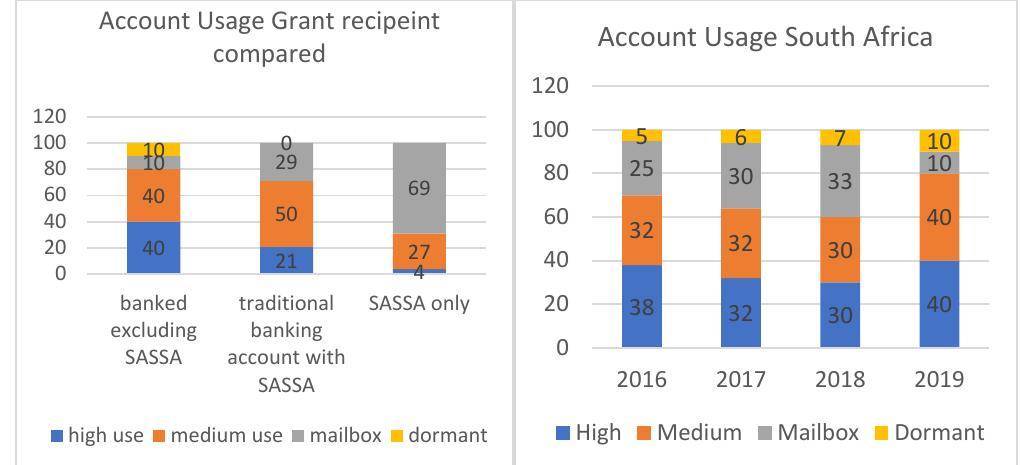
Figure 2. Bank account usage 2016 to 2019 Source: (FinMark Trust 2018, 2019, 2020).